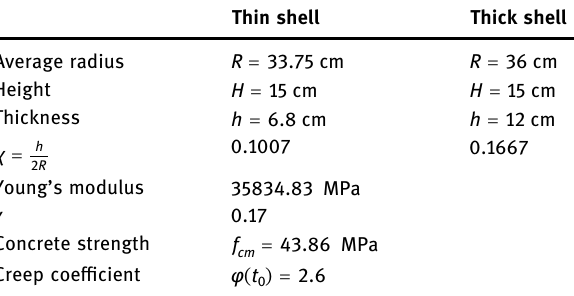
Table 1: Dimensions of ring specimens used and properties of concrete